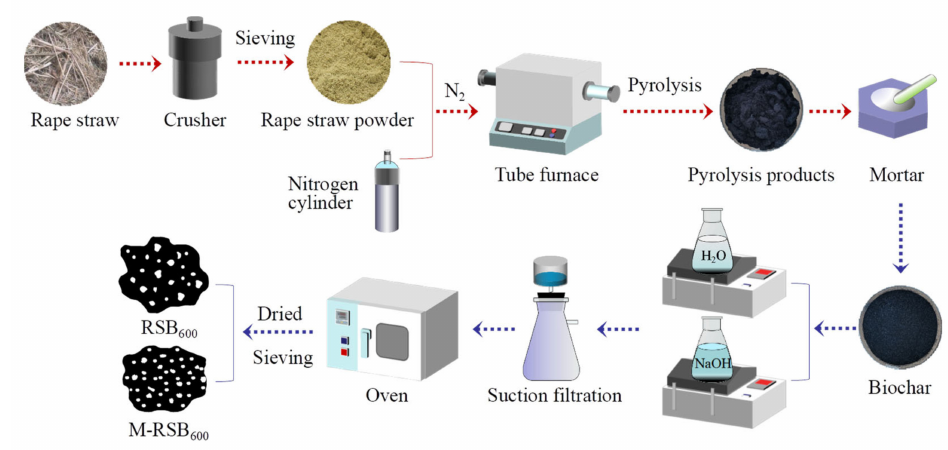
Figure 1. Preparation and modification process of